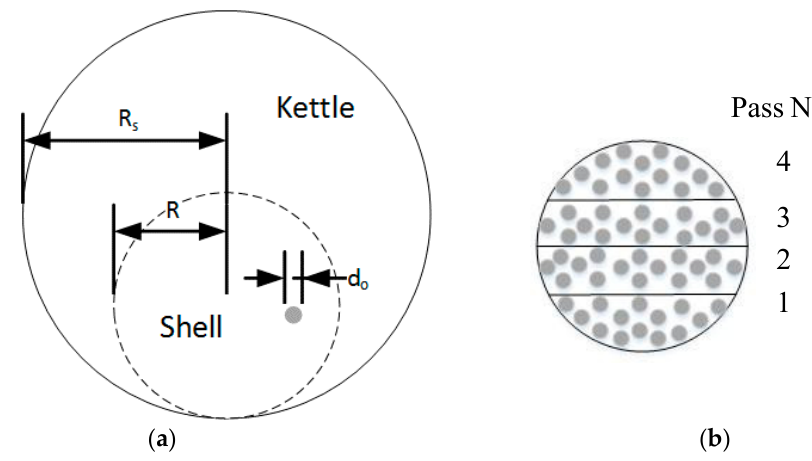
Figure 6. Kettle boiler cross section: ( a ) shell and ( b ) tube sheet.